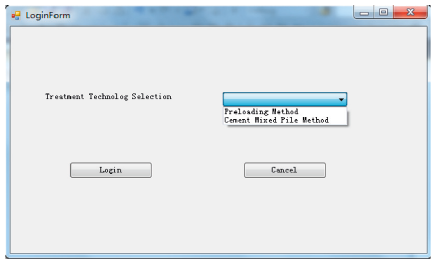
Figure 8: The login form.